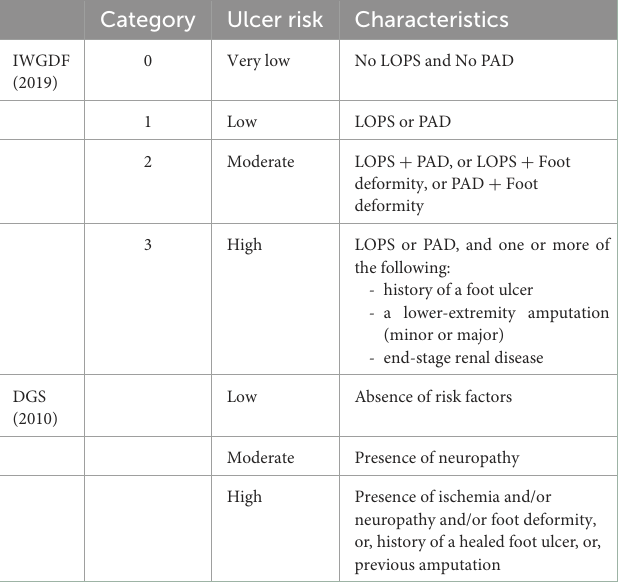
TABLE 4 Risk assessment classifications. Category Ulcer risk